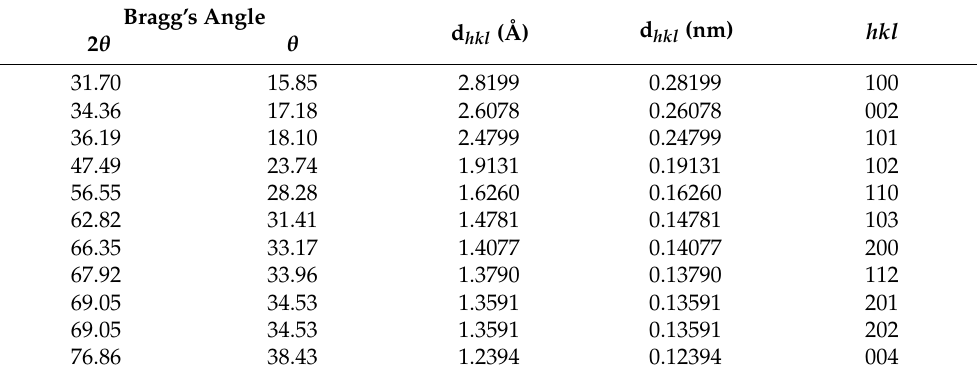
Table 4. d-spacing calculations for ZnNit powder.